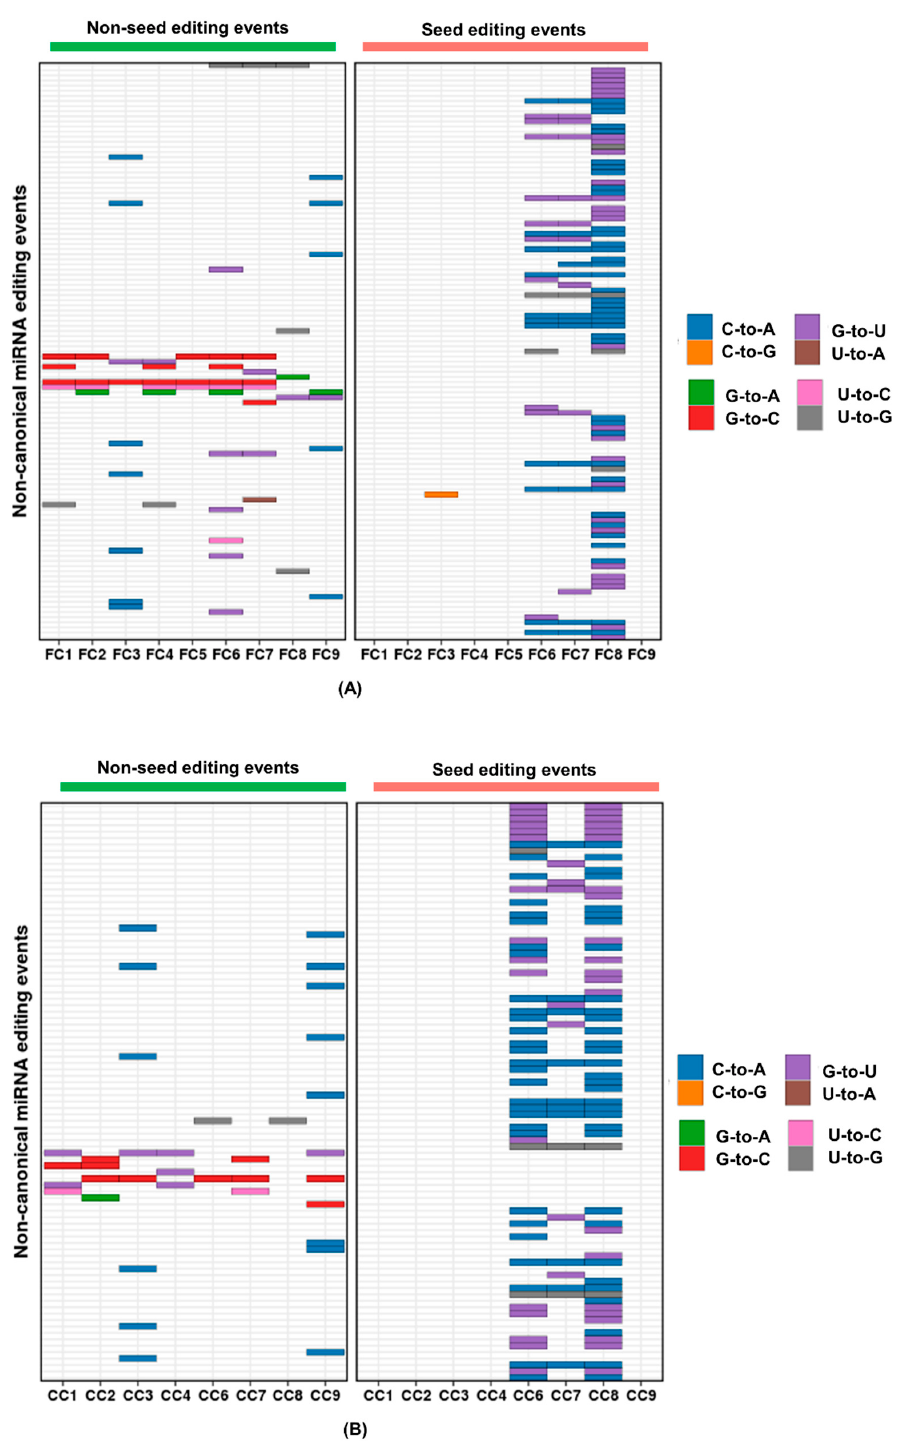
Figure 2. Distribution of different non-canonical editing within mature miRNAs. The different colours represent the types of non-canonical editing and their distribution within mature miRNA detected in ( A ) FC and ( B ) CC. The pink and the green bar over the panels correspond to seed and non-seed editing events from Figure 1. The events are alphabetically arranged according to miRNA name. For details, refer to Supplementary Table S2. A-to-U modification was not detected in the study. C-to-G and U-to-A modifications were not detected specifically in CC.